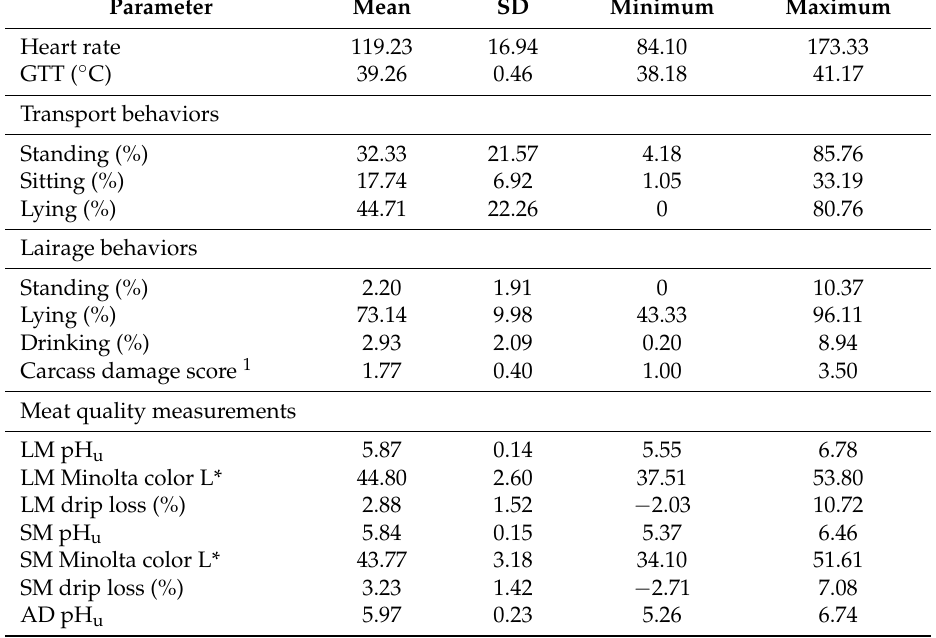
Table 3. Descriptive statistics for heart rate, gastrointestinal tract temperature (GTT), transport and lairage behavior and pork quality values (as assessed in the longissimus , LM, semimembranosus , SM, and adductor , AD, muscles), and carcass damage